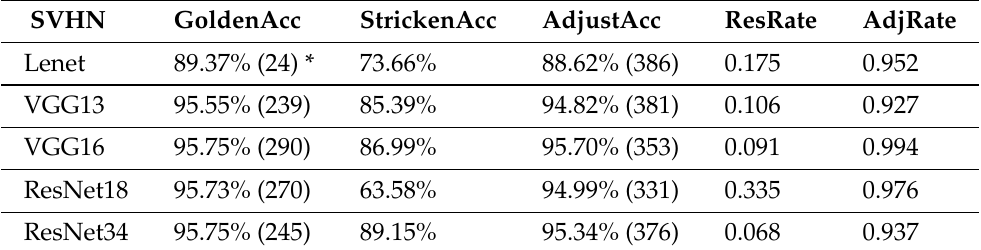
Table 3. SVHN with various models.